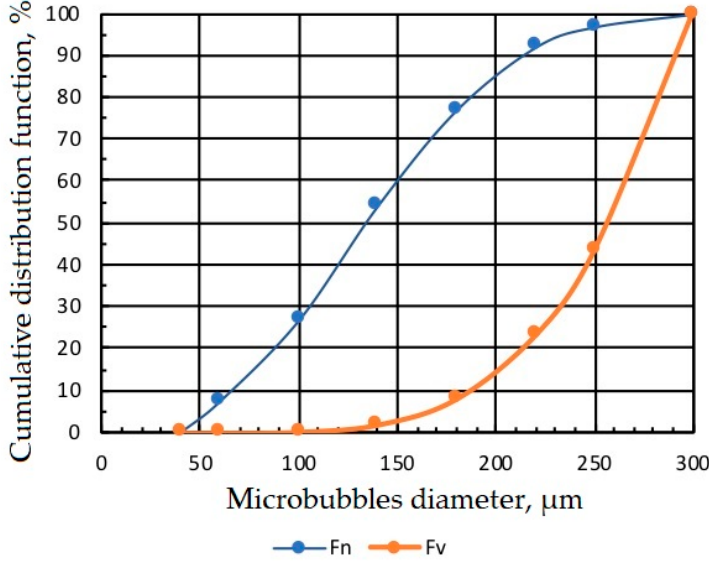
Figure 5. Numerical Fn and volume Fv cumulative distribution functions of microbubbles.